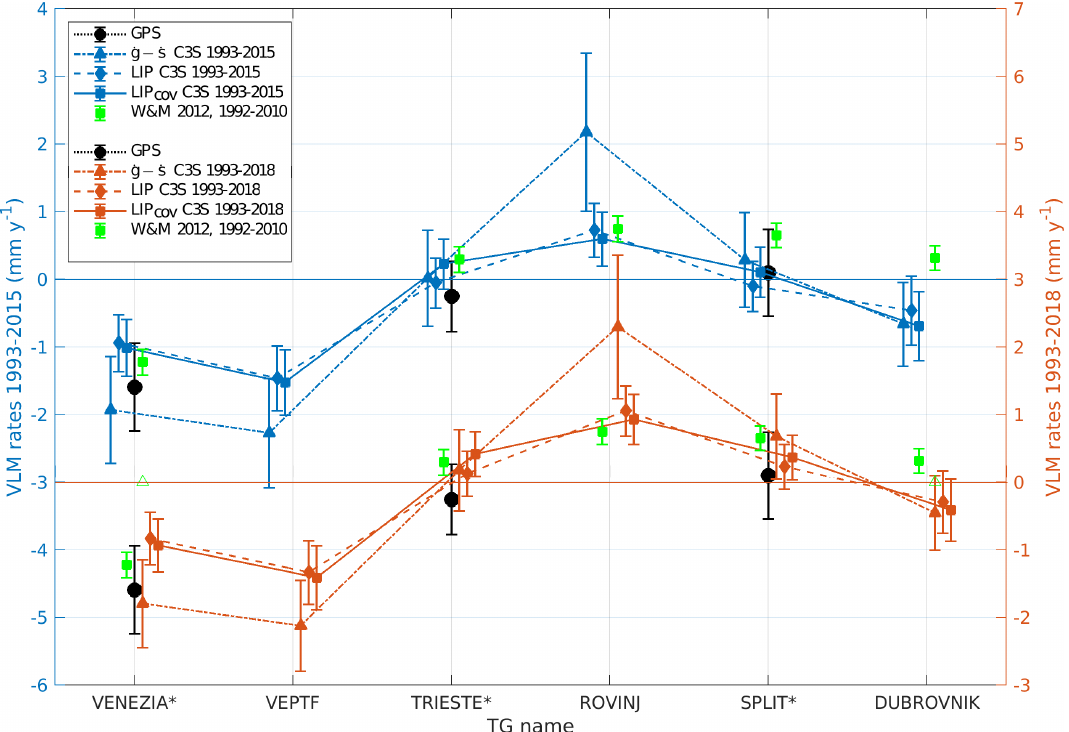
. . g − s ), LIP method, and LIP cov